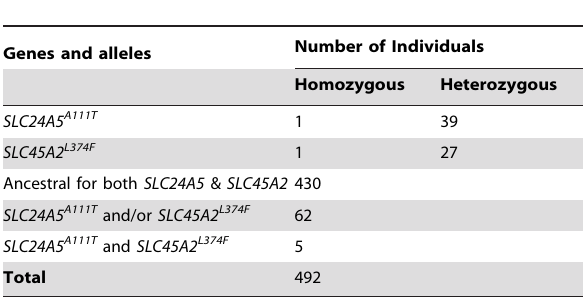
Table 2. Orang Asli genotype combinations for SLC24A5 and